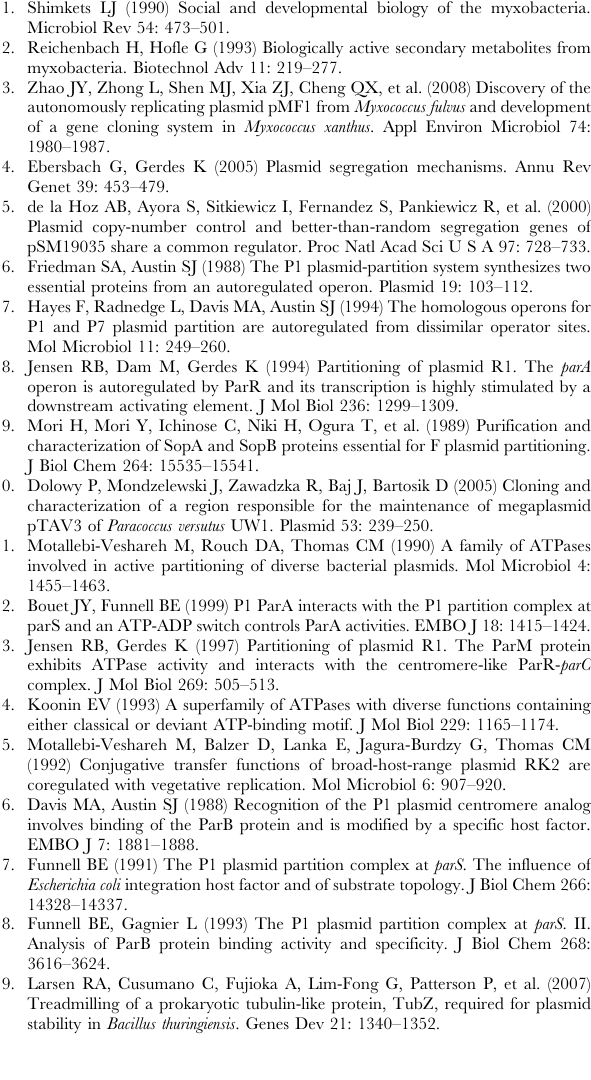
4, pXS14; lane 5, pXS16; lane M, supercoiled DNA ladder markers. The size of each band is labeled on the right of the panel.